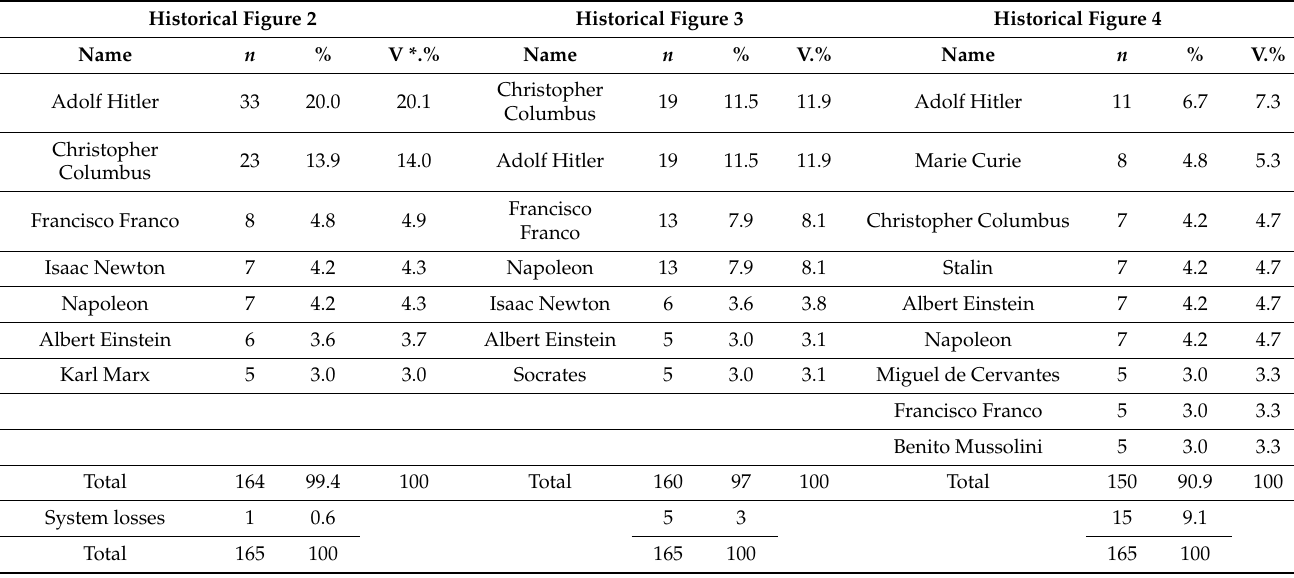
Table 3. Figures most chosen in second, third, and fourth place.